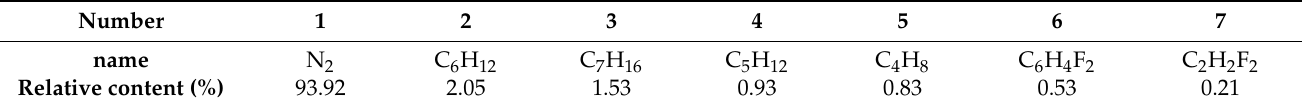
Table 4. Gas composition during pyrolysis detected by